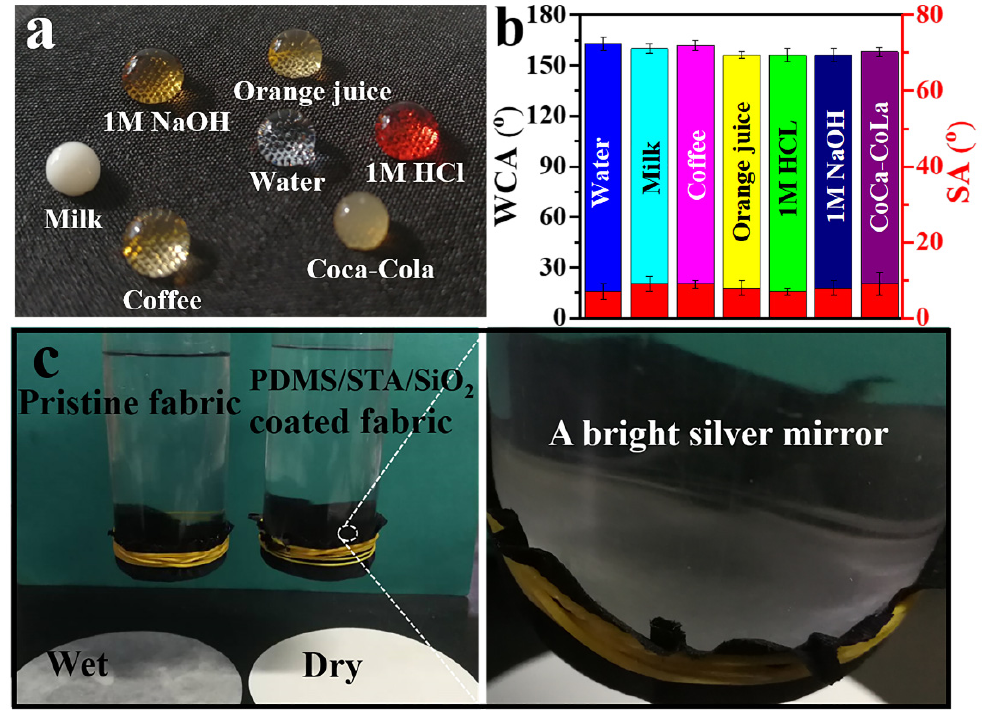
Figure 4. ( a ) Images of different kinds of liquids dropped on the PDMS/STA/SiO 2 -coated fabric. ( b ) contact angles (CAs) and sliding angles (SAs) of different liquids dropped on the PDMS/STA/SiO 2 - coated fabric. ( c ) Waterproof performance of pristine and coated fabrics and a bright silver mirror-like surface observed on the waterlogged side of the PDMS/STA/SiO 2 -coated fabric.